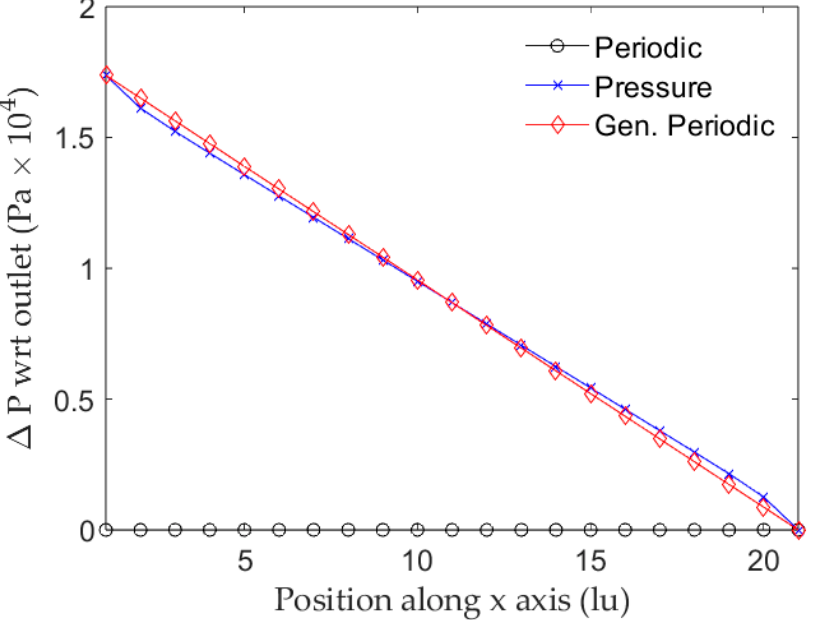
Figure 11. Pressure-drop results from generalized periodic, pressure, and periodic boundary con- ditions in a slit nanopore. Y axis represents pressure difference with respect to the outlet.